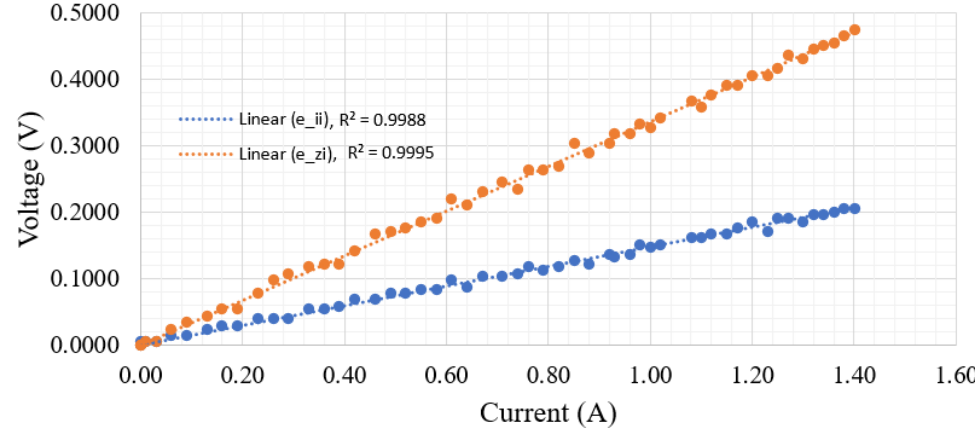
Figure 6. Influence of the current on both sensors.